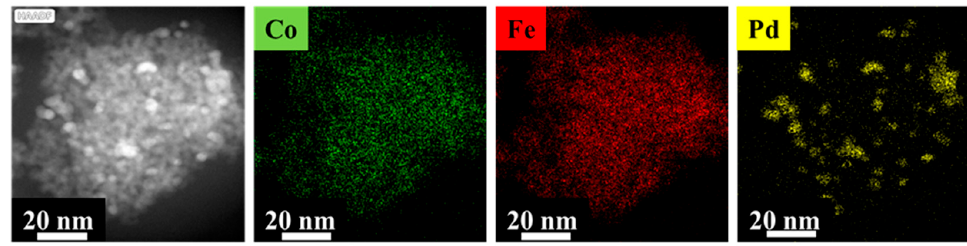
Figure 5. Element maps of the Pd/CoFe 2 O 4 -NH 2 catalyst.